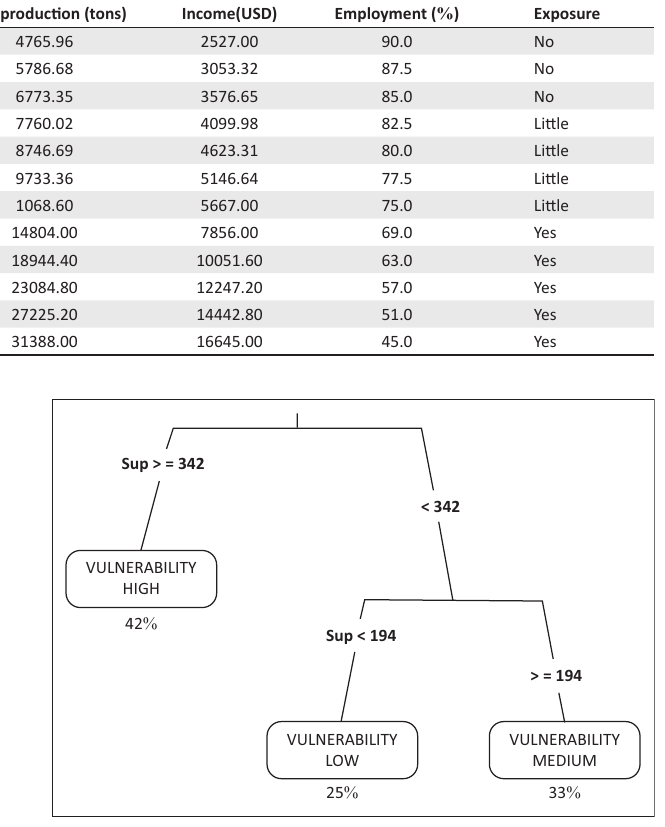
FIGURE 4: Error rate for the tree generation with the Classification and Regression Tree model.